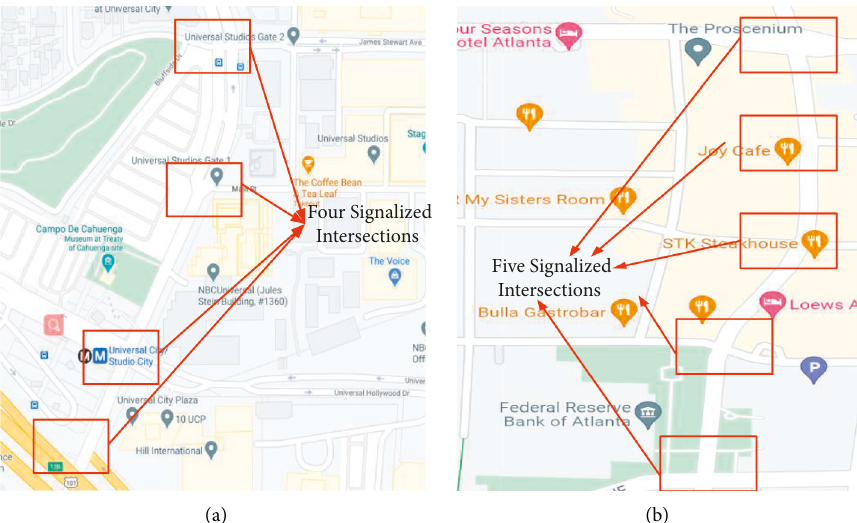
Figure 1: Schematic of the data collection area. (a) Lankershim Boulevard for data training. (b) Peachtree Street for data validation.